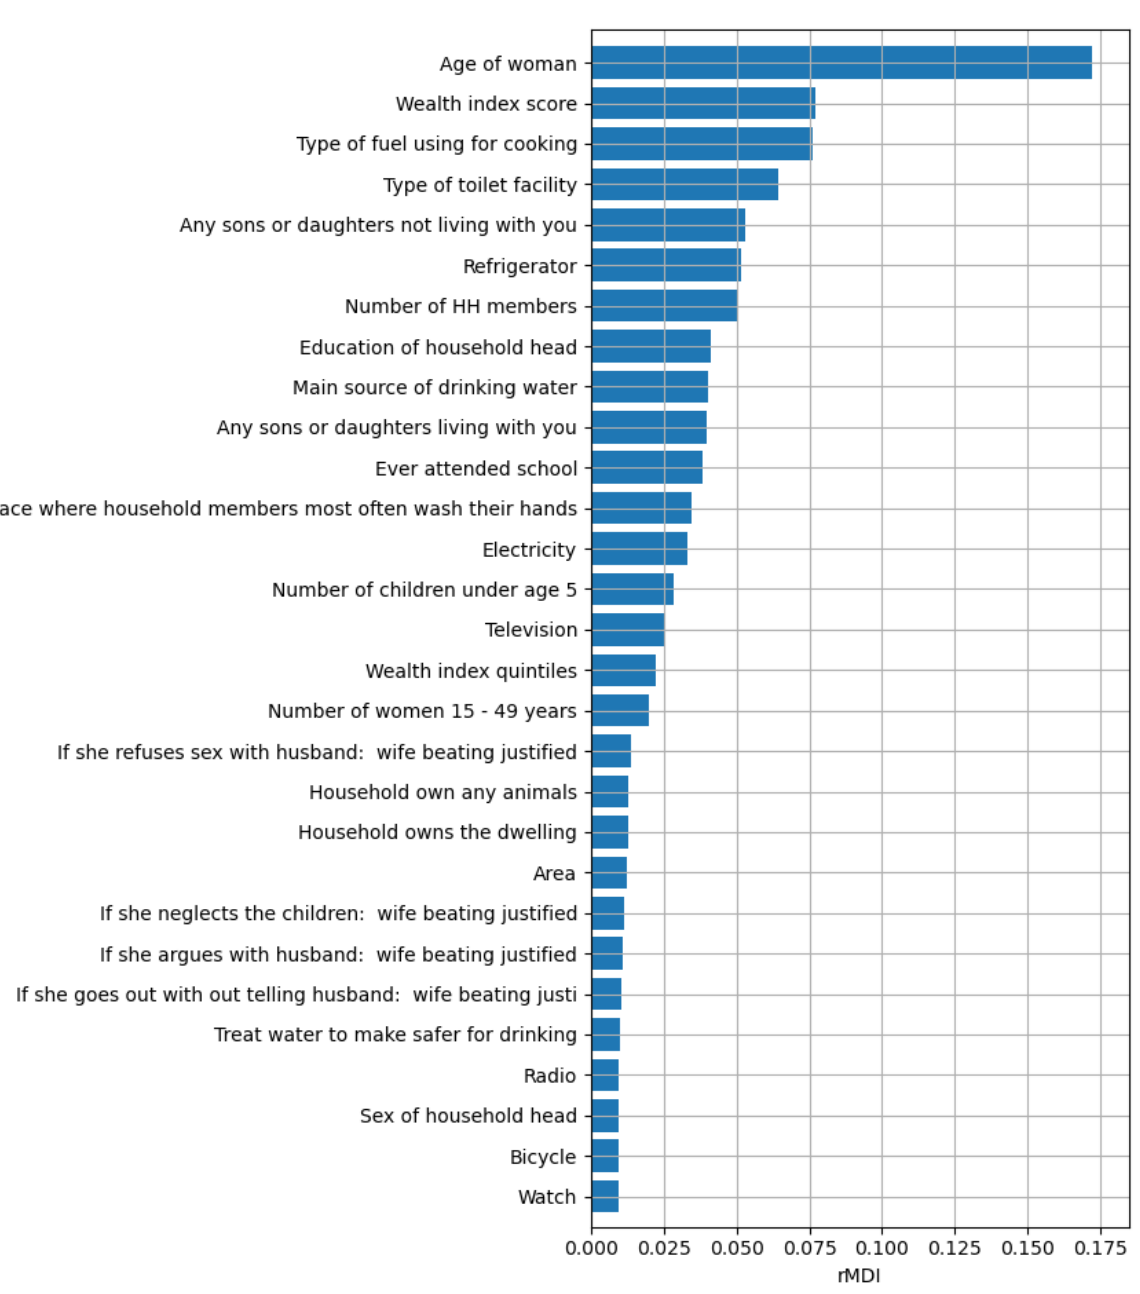
Figure 1. The 29 most important MICS indicators ranked according to the relative Mean Decrease Impurity (rMDI) metric. The top 10 indicators naturally fall into 3 groups: 2 (#1 and #8) refer to characteristics of the mother or head of household, with older maternal age (rMDI = 0.172) and education of the head of the household (rMDI = 0.041) associated with greater likelihood of having had a child who died before the age of 5. Five of the top 10 predictors of CM refer to characteristics of the home environment, including #2 family wealth index score (rMDI = 0.077), #3 fuel used for cooking (rMDI = 0.076), #4 toilet facilities (rMDI = 0.064), #6 availability of refrigeration (rMDI = 0.052), and # 9 drinking water (rMDI = 0.04). Three personal characteristics of the household complete the top ten: #5 other (living) children not living in the household (rMDI = 0.053), #7 the number of household members (rMDI = 0.051), and #10 the number of children living in the household (rMDI =